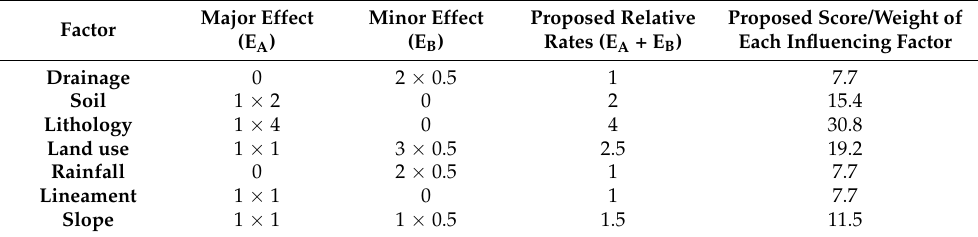
Table 2. The values of major, minor, relative rates, and proposed weights of the influencing fac- tors.